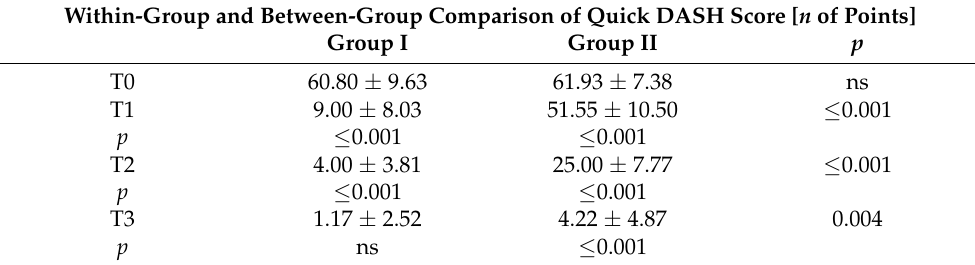
Table 3. Comparison of the functional assessment results obtained in the studied groups between the individual follow-up